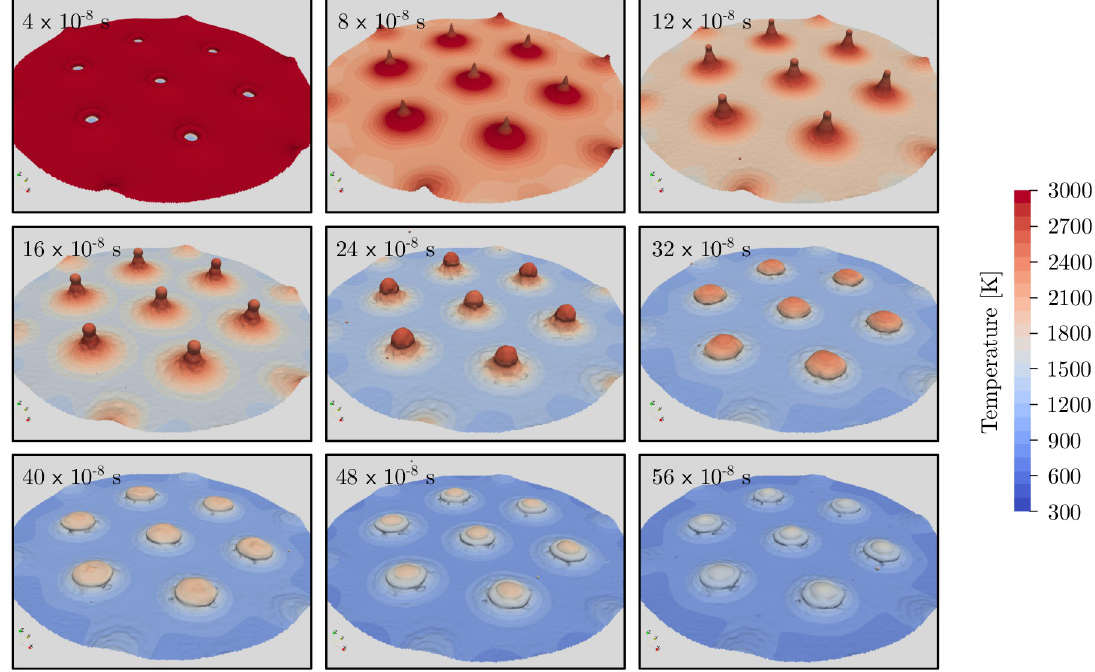
Fig 10. Simulated, three-dimensional surface structures at different time steps for the radial polarization orientation at a laser fluence of 4.8 J/cm 2 .